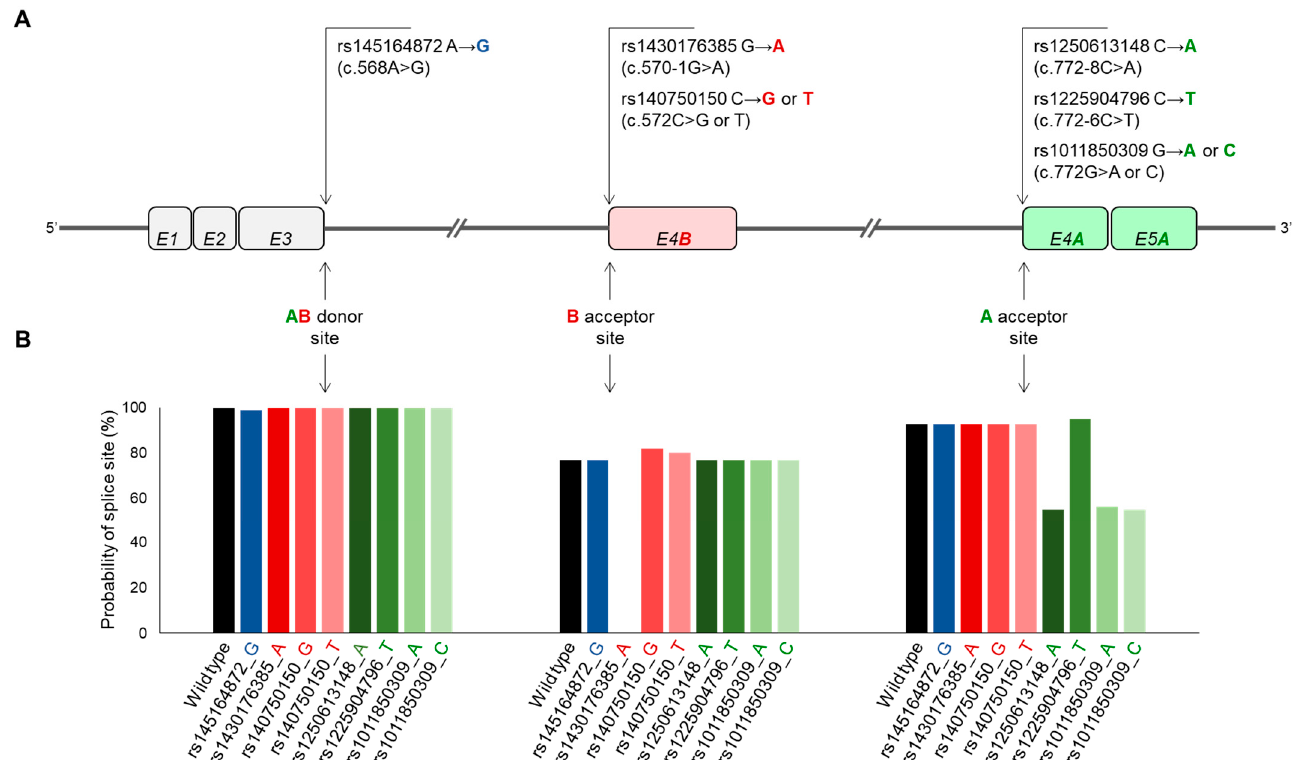
Figure 5. Effect of natural sequence variations predicted by the NetGene2-2.42 program on the recognition probability of SCD5A - and SCD5B -specific donor and acceptor sites. ( A ) Position of SNVs a ff ecting donor and acceptor sites critical for alternative splicing in the SCD5 gene. Exons are numbered and marked with rectangles. SCD5A- and SCD5B -speci fi c, as well as shared exons are shown in green, red and gray, respectively. In addition to localization, nucleotide exchanges caused by SNVs are also indicated. ( B ) Probabilities of donor and acceptor sites for SCD5 sequence variants predicted by NetGene2-2.42, as indicated in Section 4. Probabilities are plo tt ed as a function of sequence variations at a given donor or acceptor site. The black, blue, green and red columns in the diagram refer to wild type, AB donor site SNV, B acceptor site variants and A acceptor site variants, respectively.